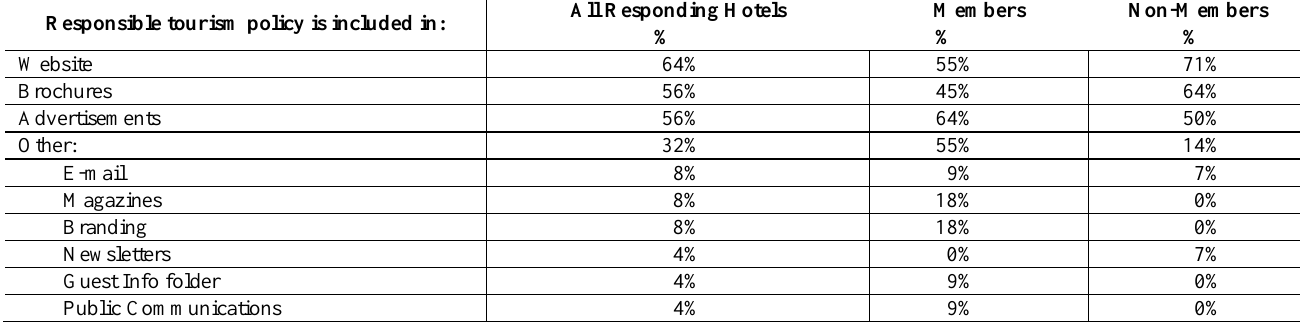
Table 8: Where Responding Hotels Included their Responsible Tourism Policy